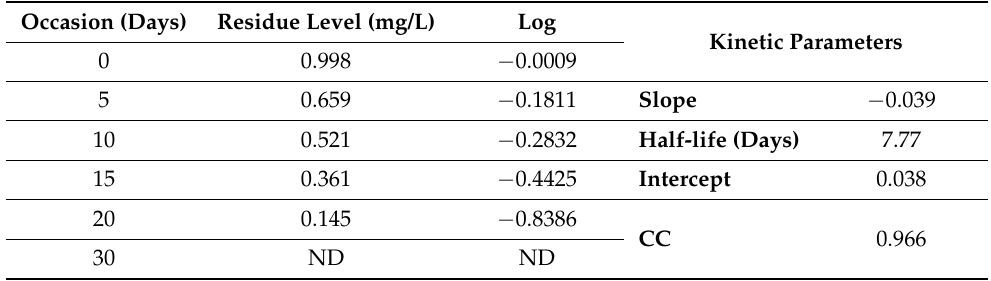
Figure 10. Graph representing the dissipation curve of photocatalytic decontamination of mancozeb in water under direct sunlight. Table 2. The photolytic summarized results of kinetic